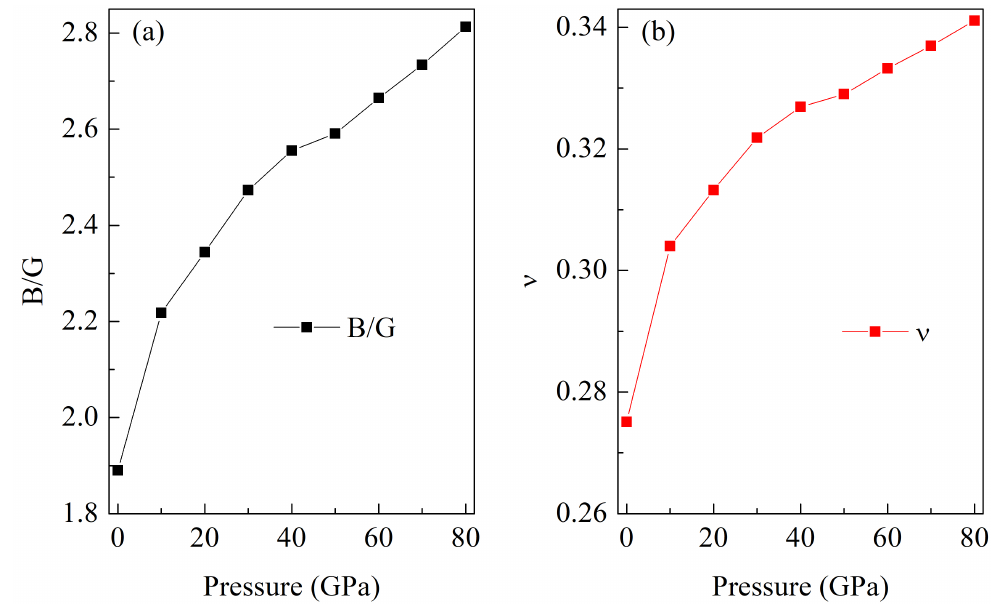
Figure 6. G/B ( a , b ) versus the applied pressure for β -Mg 17 Al 12 .